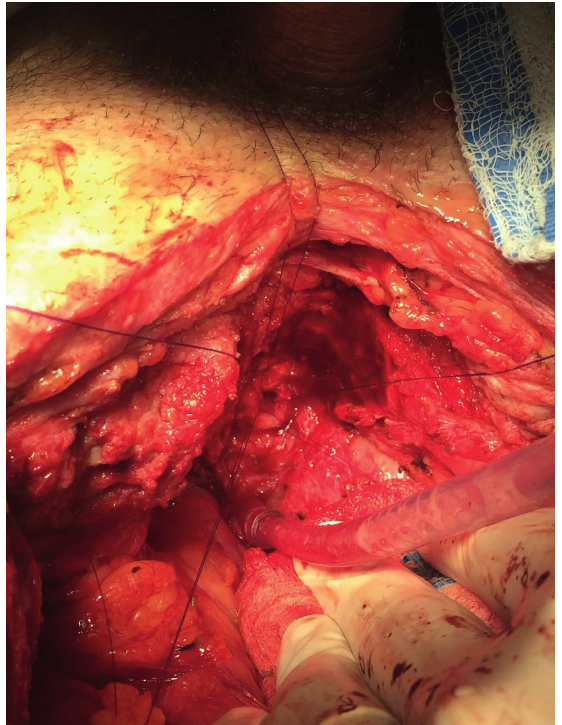
Figure 3 - Urethral lumen previous to re anastomosis by abdominal approach. Note that the pubectomy provide a comfortable surgical access to the stricture area.